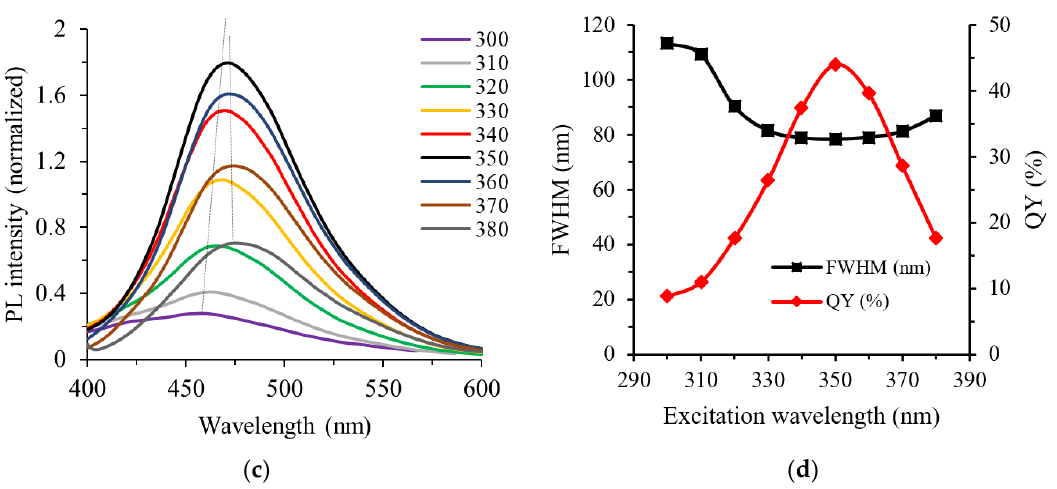
Figure 3. ( a ) Absorption spectra of undoped and N–CDs, ( b ) fluorescence PL spectra of undoped and N–CDs excited at 350 nm, with A 350 = 0.04, ( c ) PL spectra of N–CDs under various excitation wavelengths (300–380 nm) and ( d ) emission full width at half maximum (FWHM) and quantum yield (QY) as a function of excitation wavelength. The inset in panels ( a ) for the corresponding photographs under 365 nm UV light and ( b ) the corresponding calculated QYs.